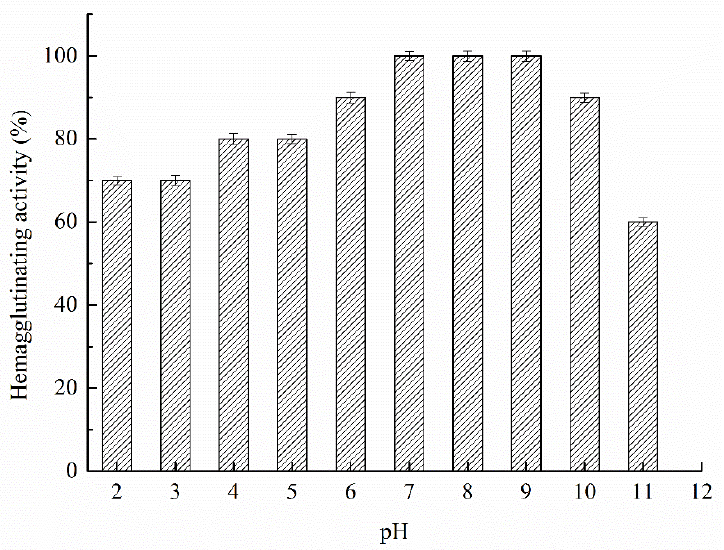
Figure 8. The hemagglutinating activity of the lectin from the Zihua snap bean at various pH conditions.